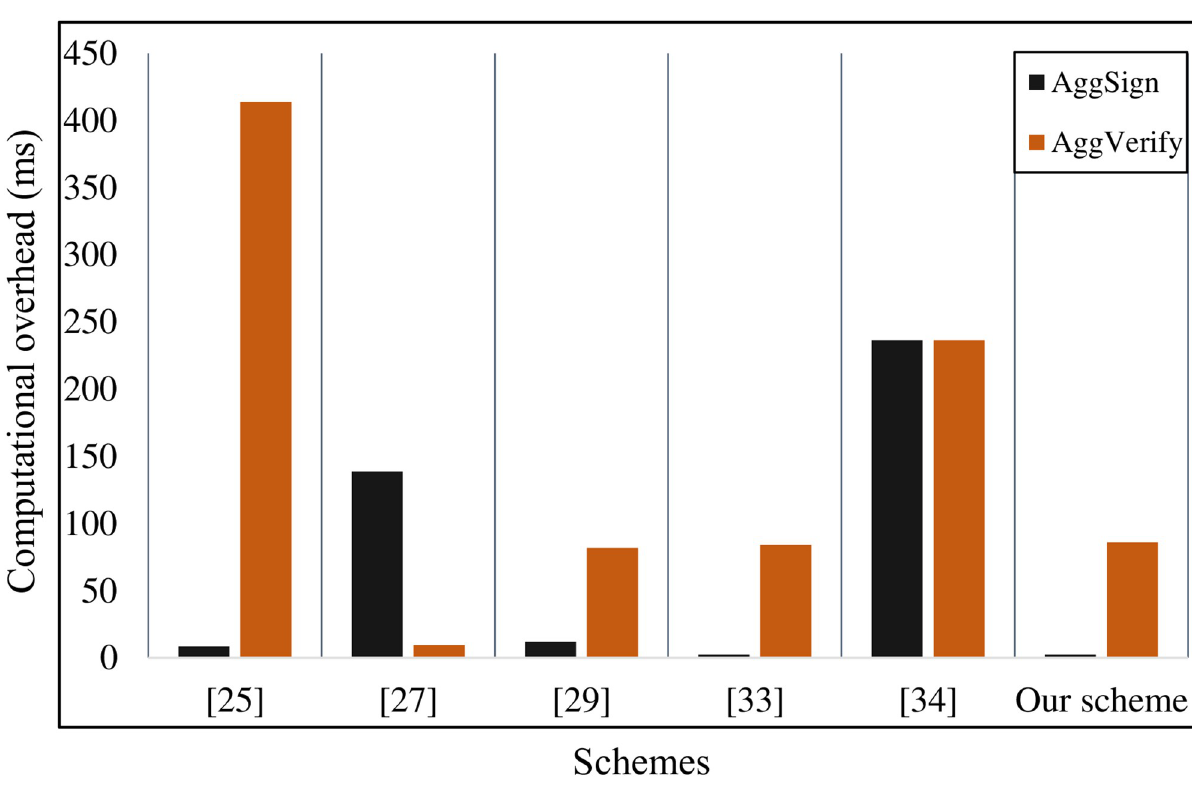
Fig 3. Computational overhead of the aggregate signing and aggregate verification.